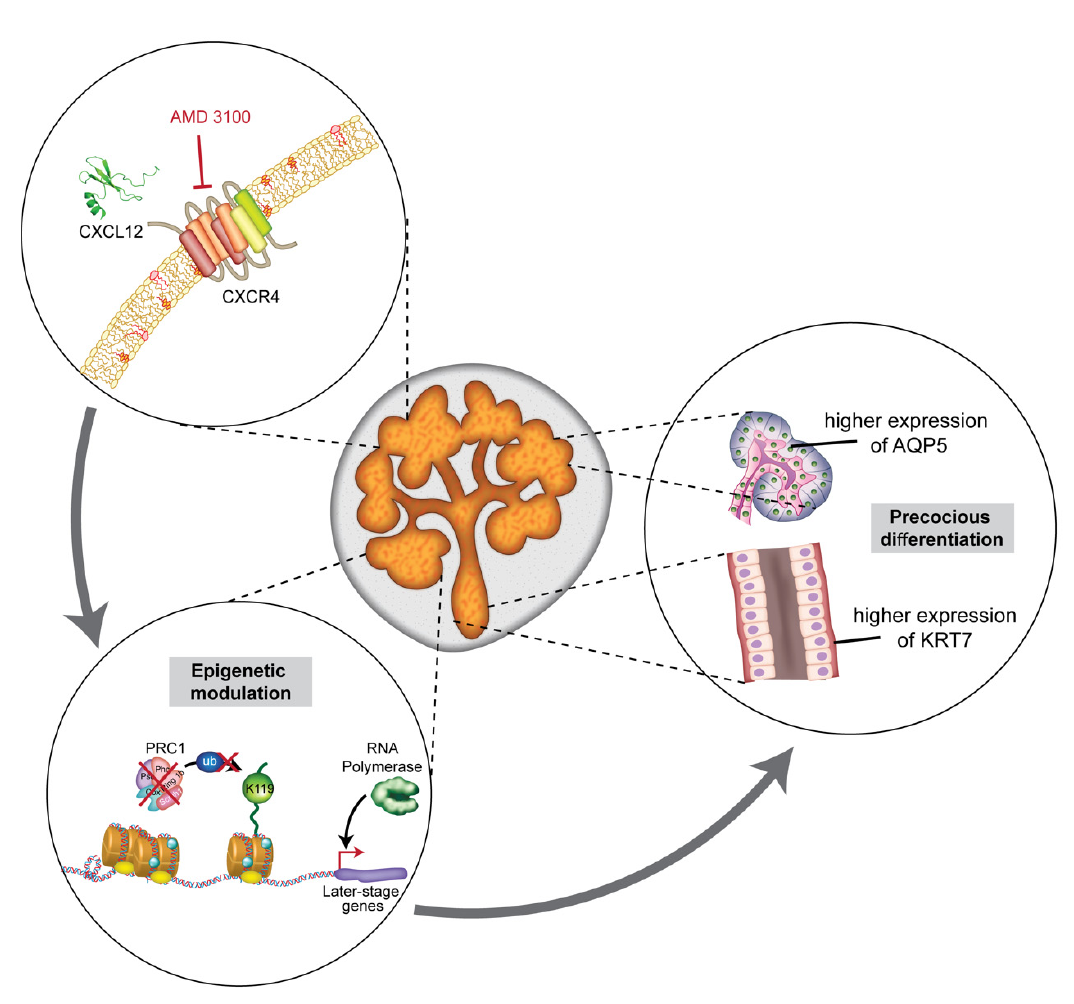
Figure 6. Schematic for AMD3100-induced epigenetic modulation and precocious differentiation in eSMGs. The treatment of eSMGs with AMD3100 is followed by down-regulation of PRC1 components, leading to the absence of ubiquitin-ligating activity on H2AK119, which, in turn, deprives the DNA of its condensing function. Such epigenetic modulation confers de novo or stronger transcription of later-stage developmental genes to eSMGs, promoting precocious differentiation in acini and ducts.